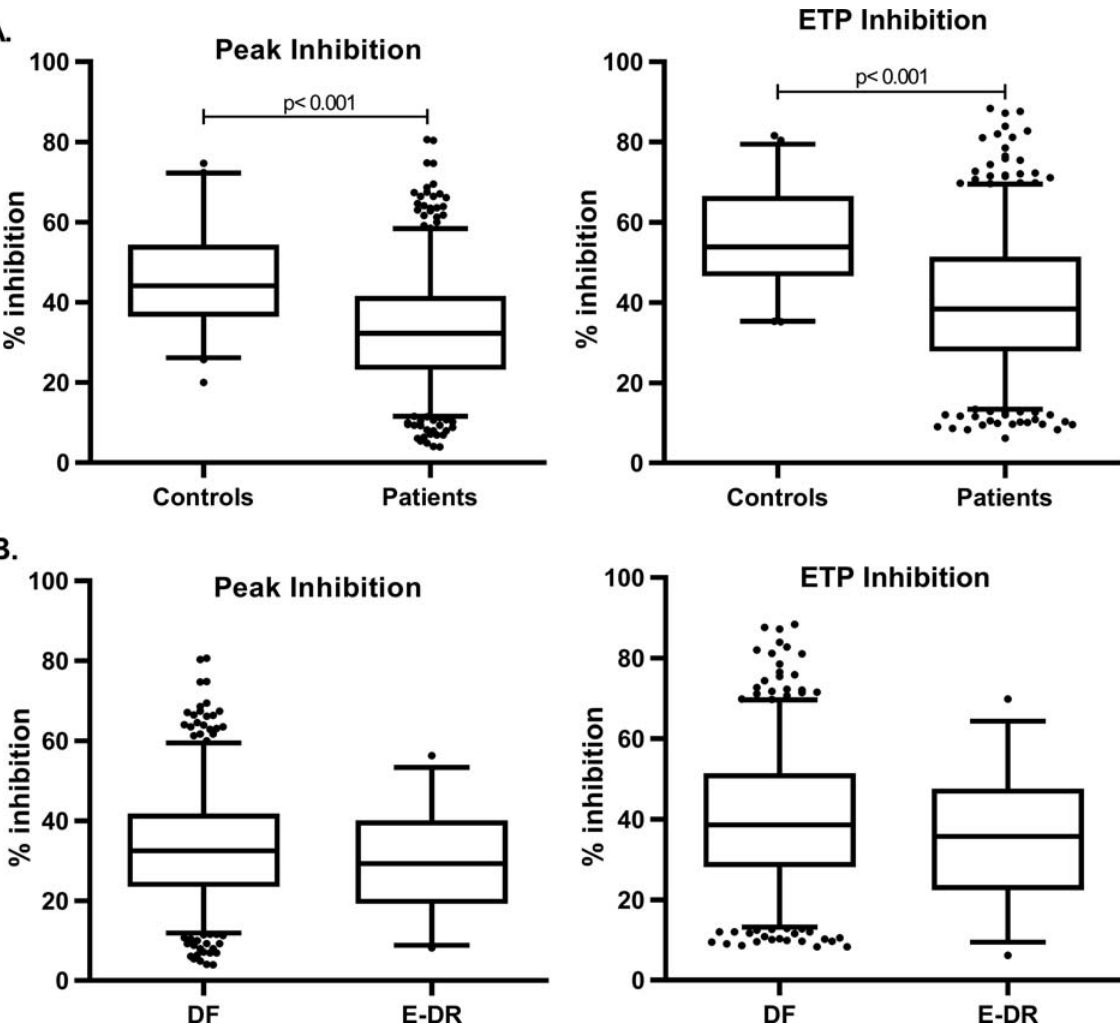
Fig. 1 Endogenous thrombin generation potential inhibition and peak inhibition ( A ) in patients compared with controls and ( B ) in patients with E-DR compared with DF. E-DR, early disease recurrence; DF, disease